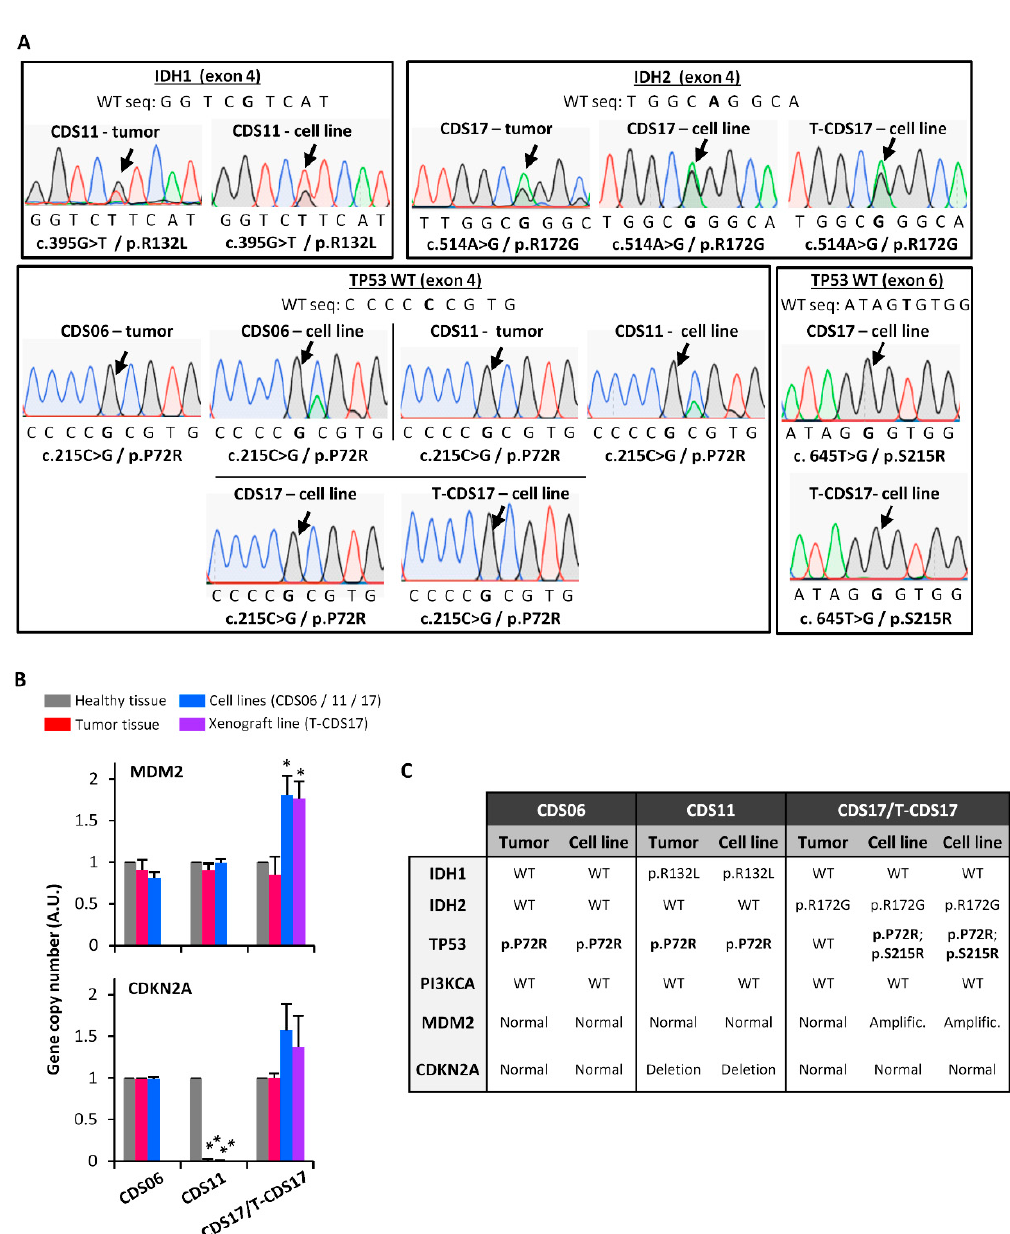
Figure 2. Genetic characterization of chondrosarcoma cell lines. ( A ) Sanger sequencing chromatograms showing mutations (black arrows) in IDH1 , IDH2 , and TP53 genes present in the indicated tumors and cell lines. Reference wild type (WT) sequences are shown. ( B ) Gene copy numbers of the indicated genes were estimated by quantitative PCR on genomic DNA. Results are expressed relative to the corresponding healthy tissue sample and are the mean and standard deviation of three experiments (*: p < 0.05; ** p < 0.005; two-sided Student’s t -test). ( C ) Summary of the genetic characterization of the indicated chondrosarcoma cell lines and tumor samples. Homozygous mutations are highlighted in bold.